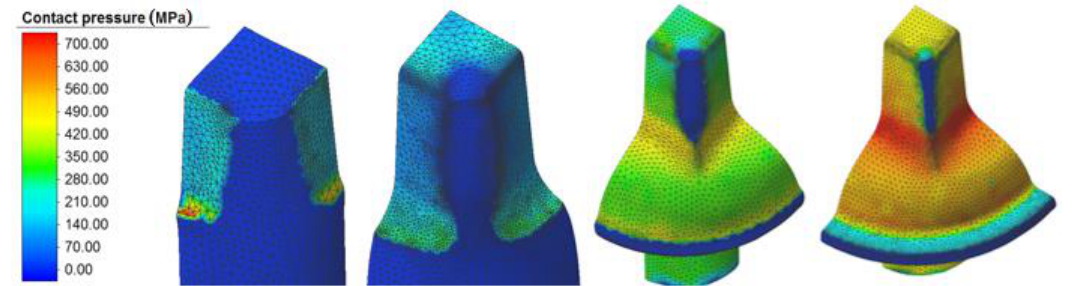
Figure 9. Contact pressure along the forming process of the head of the screw